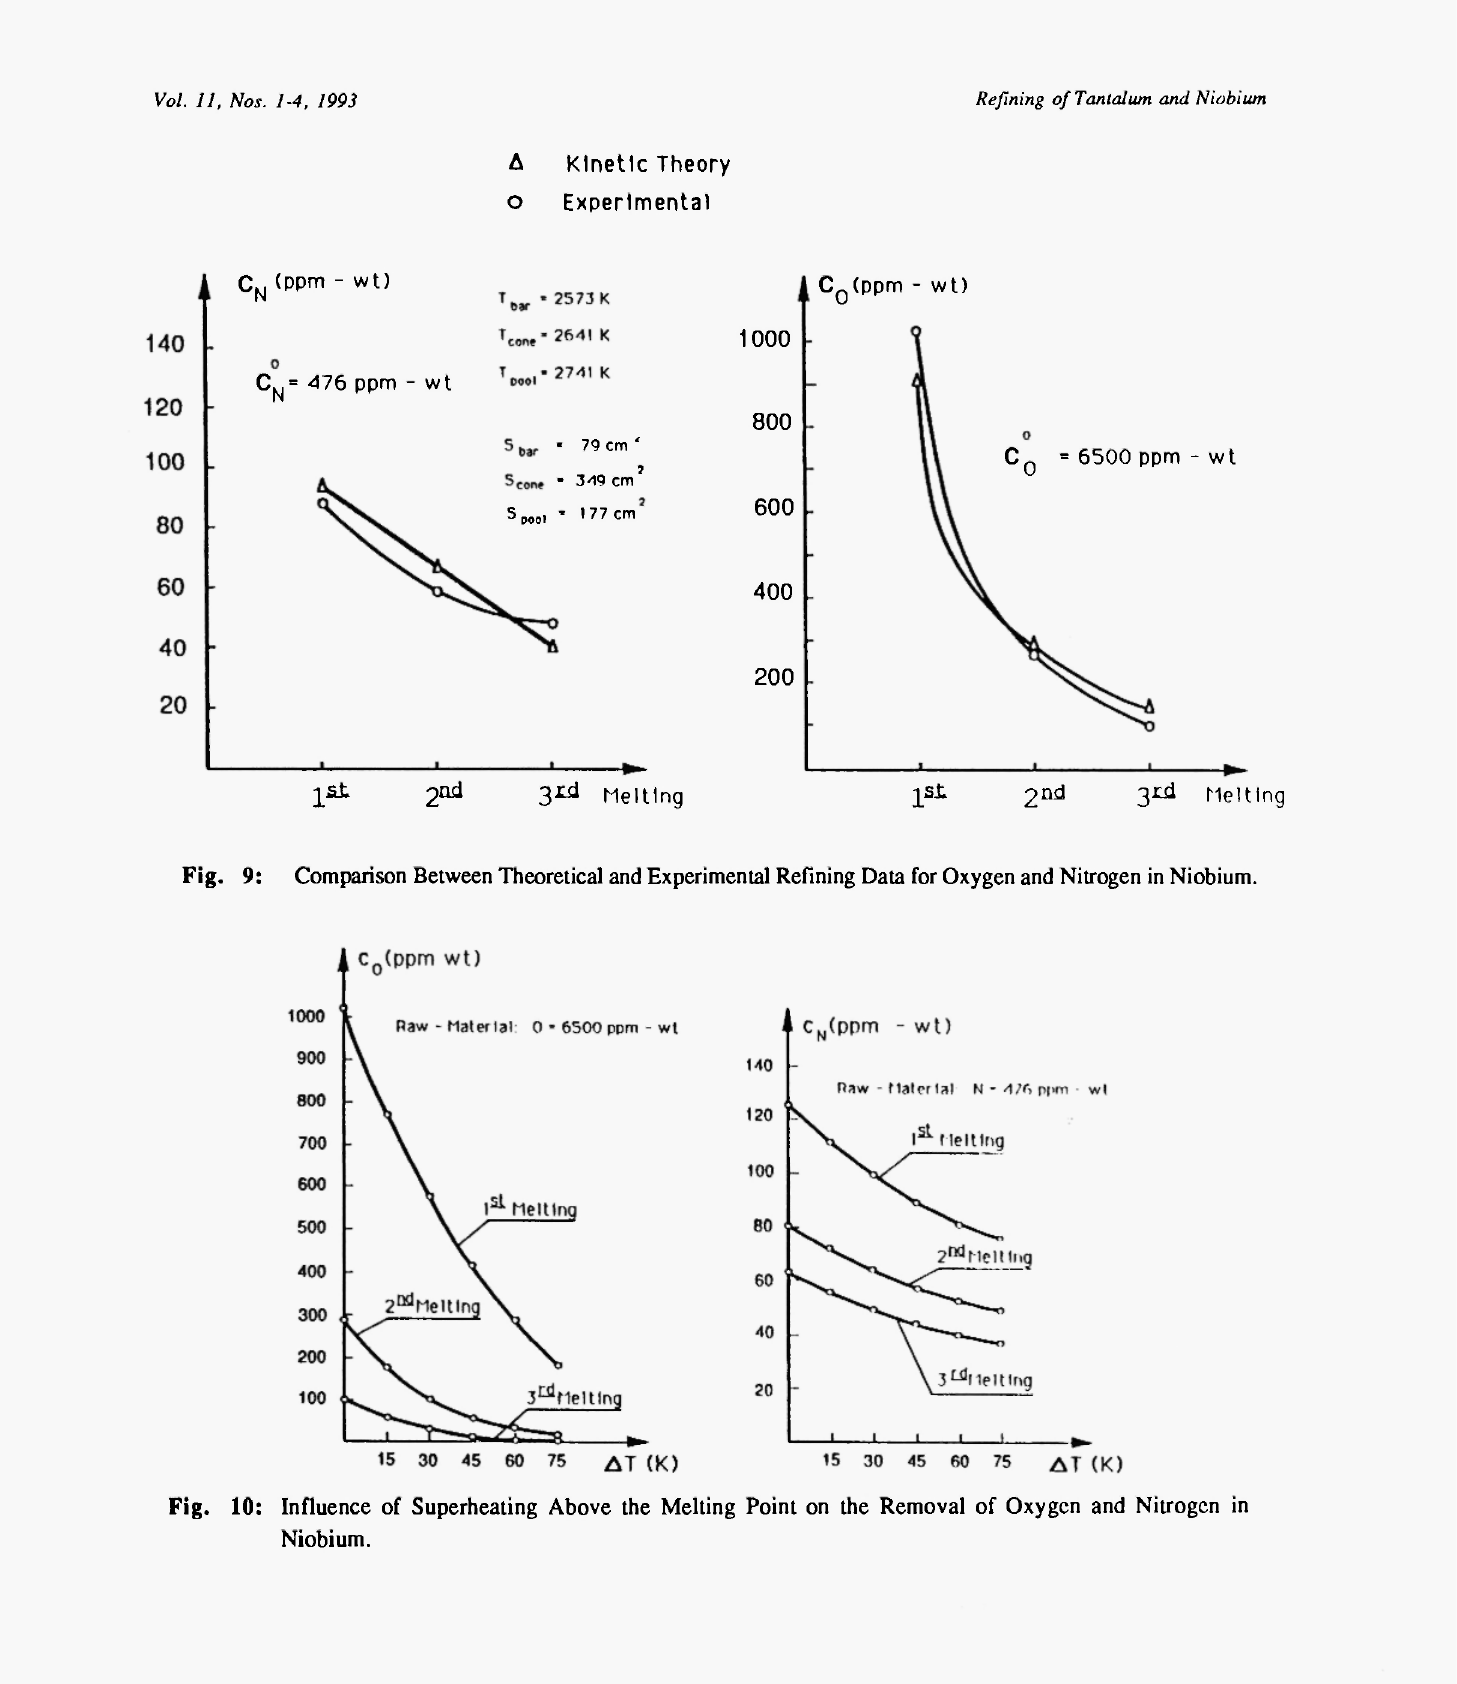
Fig. 10: Influence of Superheating Above the Melting Point on the Removal of Oxygen and Nitrogen in